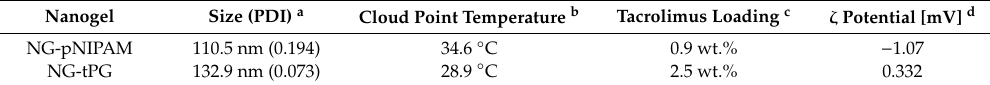
Table 1. Properties and drug loading of the investigated